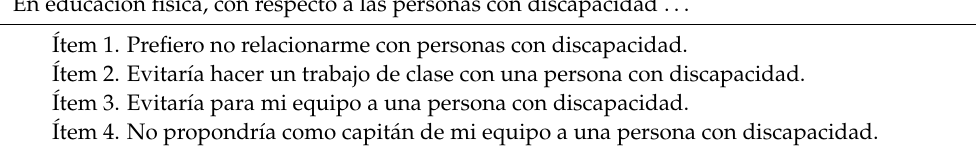
Table A1. The Attitudes (cid:48) Scale toward Students with Disabilities in Physical